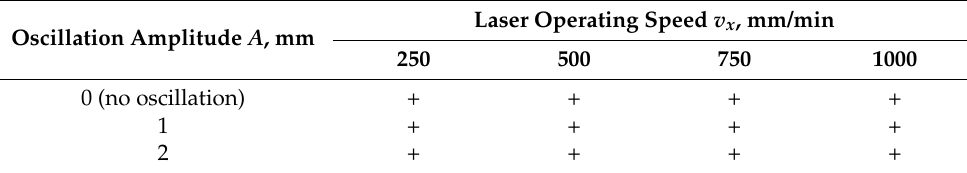
Table 1. Parameters of laser processing and number of tests.